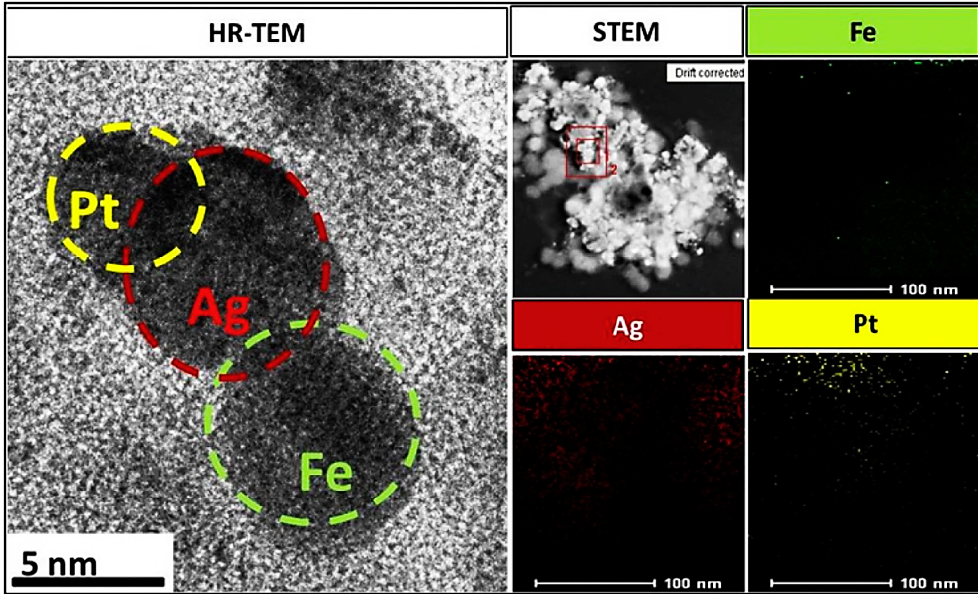
Figure 10. HRTEM images and HAADF-STEM images of Fe-Ag-Pt NPs and the elemental mapping of Pt, Fe, and Ag NPs. Reproduced from [27], with permission from Elsevier, 2017.